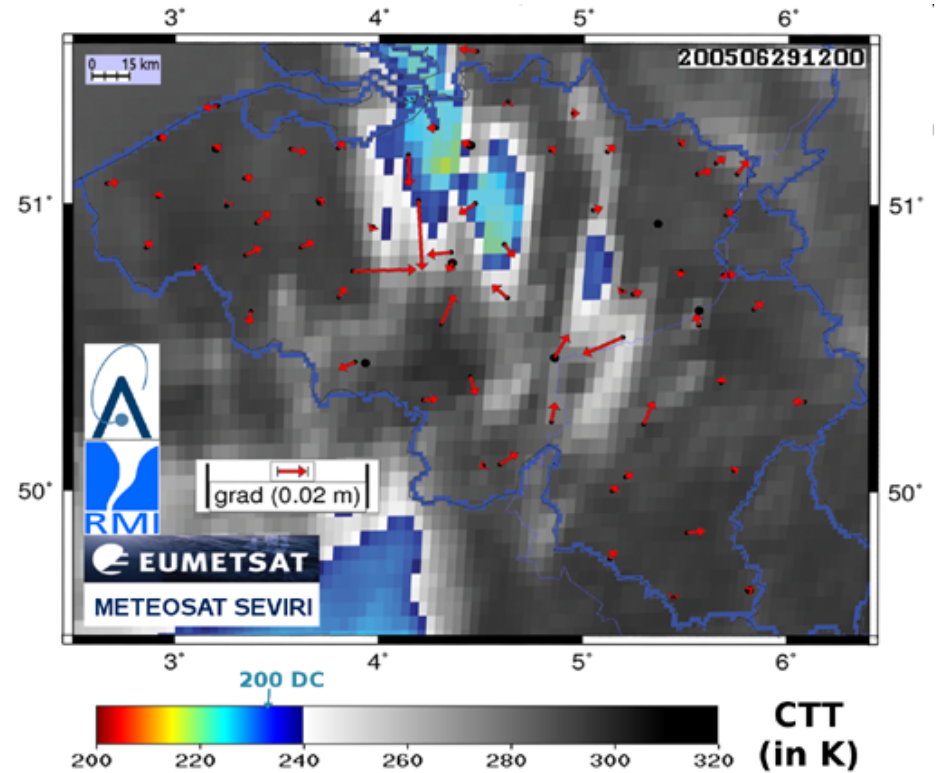
Figure 14. CTT of the 10.8µm channel of SEVIRI (in Kelvins) and GNSS gradients plotted with red arrows on stations (small black circles) at 12:05UTC (29 June 2005). Cities are in larger black